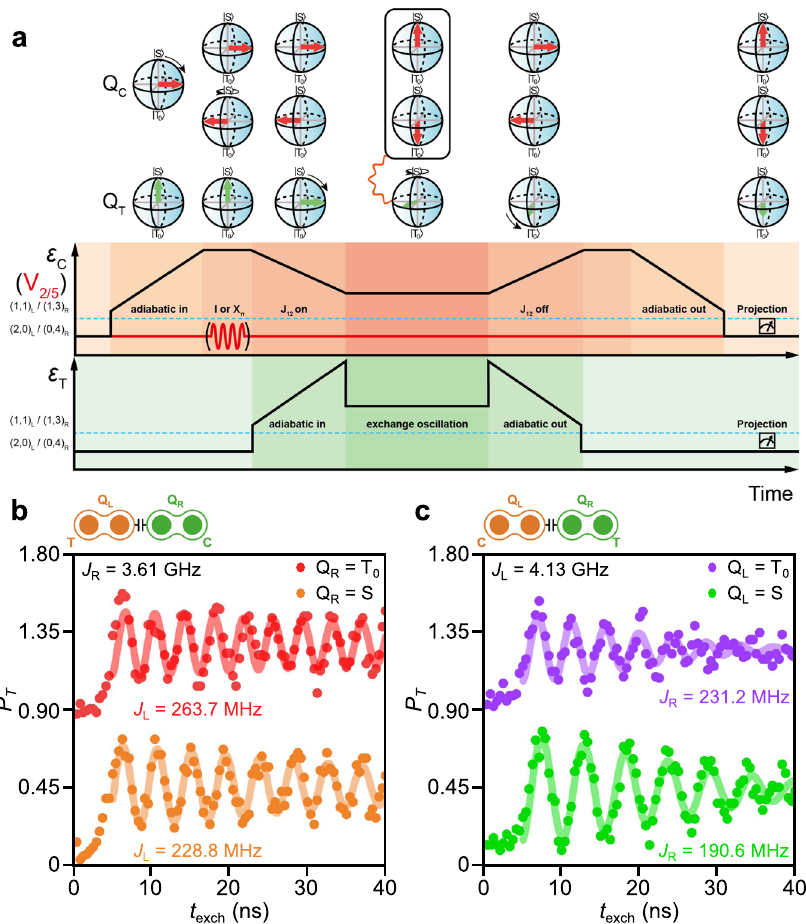
Fig. 3 Demonstration of inter-qubit coupling. a A pulse sequence to produce the control qubit (Q C ) state-dependent exchange oscillation of the target qubit (Q T ). A schematic illustration of the state of both qubits in each step is depicted in the upper panel. b , c The exchange oscillations of Q L (Q R ) depending on the state of the other qubit as control. The lower and upper traces are measured when the state of Q T is S j i and T 0 j i ,